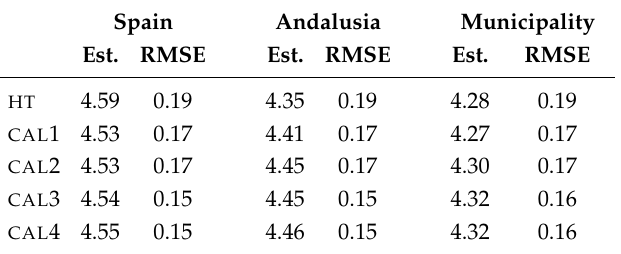
Table 8. Point estimation of proportions (in percent, %) using several methods: Calibration in one ( CAL 1) or two stages ( CAL 2, CAL 3 and CAL 4). Main variable:“Procedures of decision-making”. Estimated Root Mean Squared Error using